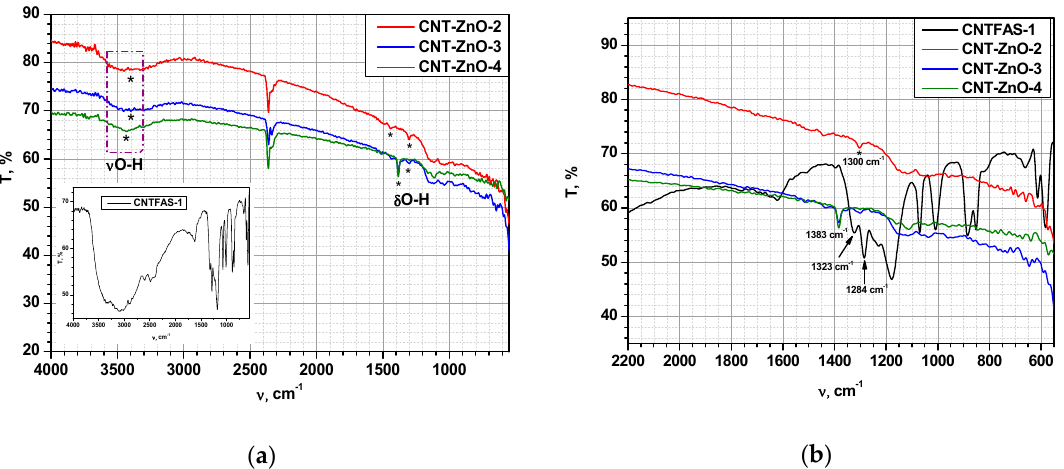
Figure 4. FTIR spectra of ZnO-CNT samples compared to functionalized CNT (CNTFAS-1) in the range of: ( a ) 4000-550 cm −1 . Inset shows FT-IR spectrum of CNTFAS-1 sample; ( b ) 2000-550 cm −1 . CNT: ZnO weight ratio for CNT-ZnO-2 = 1:10; for CNT-ZnO-3 = 1:5 and respectively for CNT-ZnO-4 = 1:4.